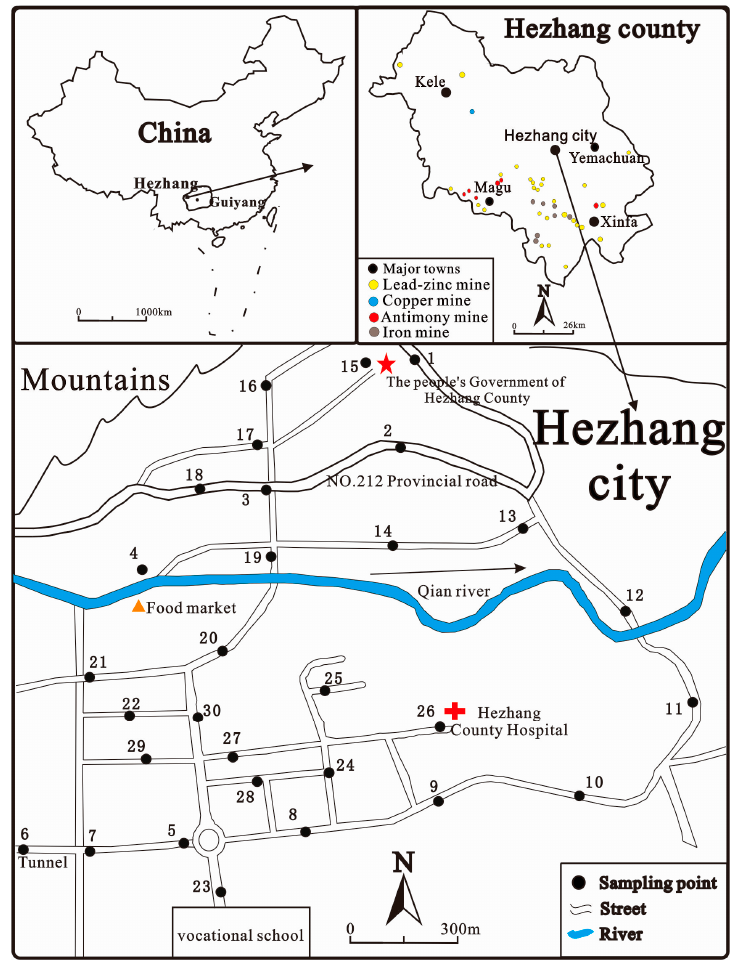
Figure 1. Sketch map showing the study area and the street dust sampling sites.